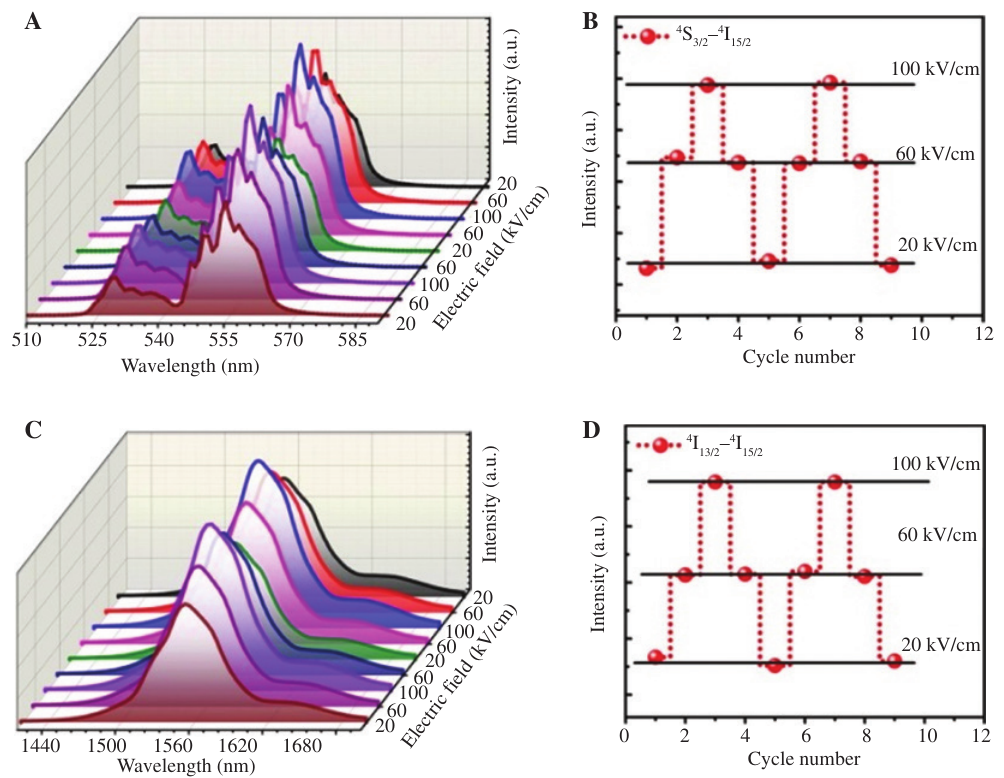
Figure 6: Non-volatile testing of electric field modified luminescence. (A) The upconversion emission spectra of one sample after pulsed electric fields. (B) Plots of upconversion emission intensity versus a circulating electric field. (C) The NIR luminescence spectra of one sample after loading pulsed electric fields. (D) Plots of NIR emission intensity versus a circulating electric